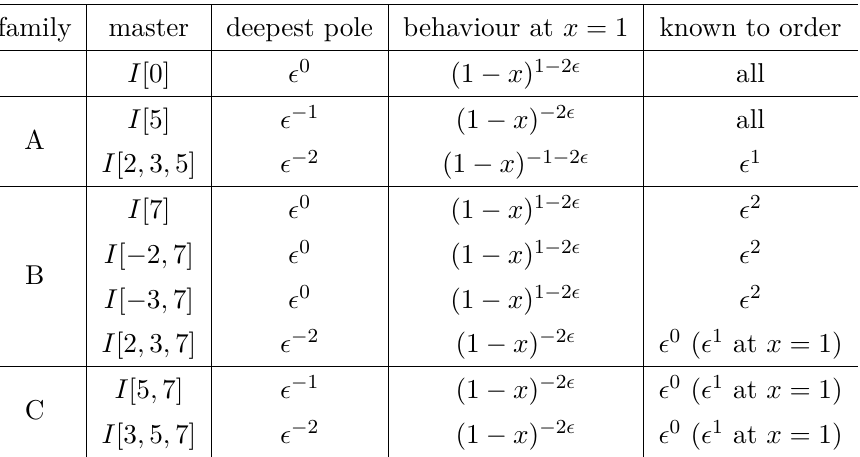
Table 1 . Summary of the double real radiation master